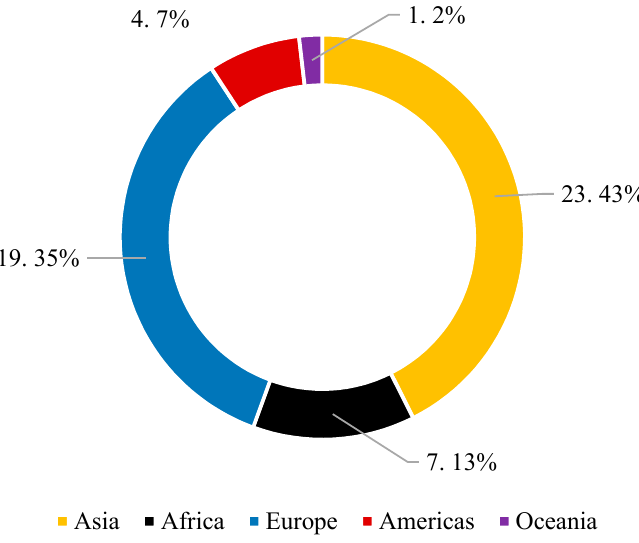
Figure 1. The origin of spice samples.